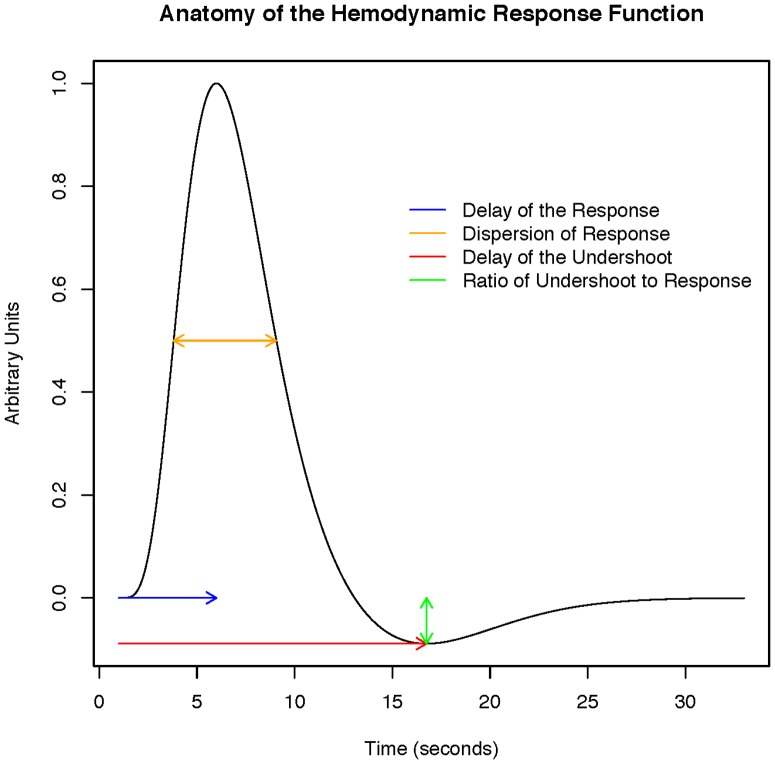
Anatomy of the HRF.